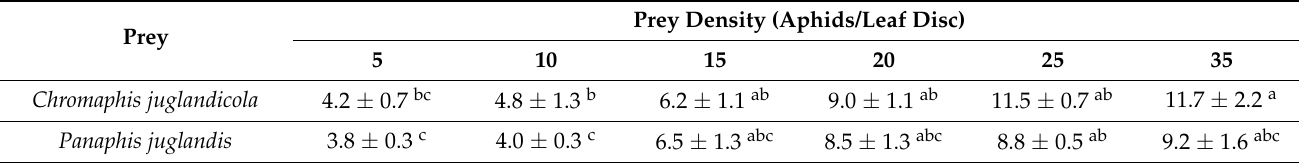
Table 1. Mean number of 2nd–3rd instar of Panaphis juglandis and Chromaphis juglandicola aphids preyed on by an Orius sauteri adult bug on walnut leaf disks over 24 h at 25 ± 2 ◦ C. Prey